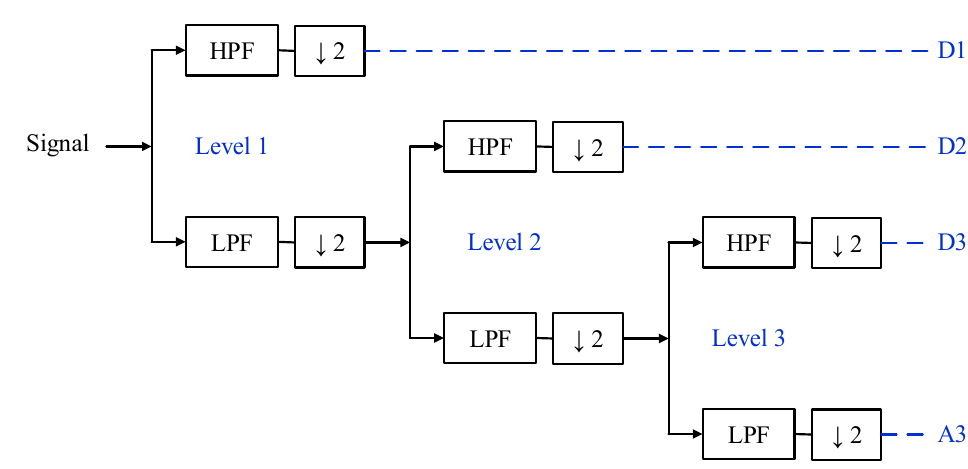
Figure 7. Decomposition of a signal into three levels using multiresolution analysis.